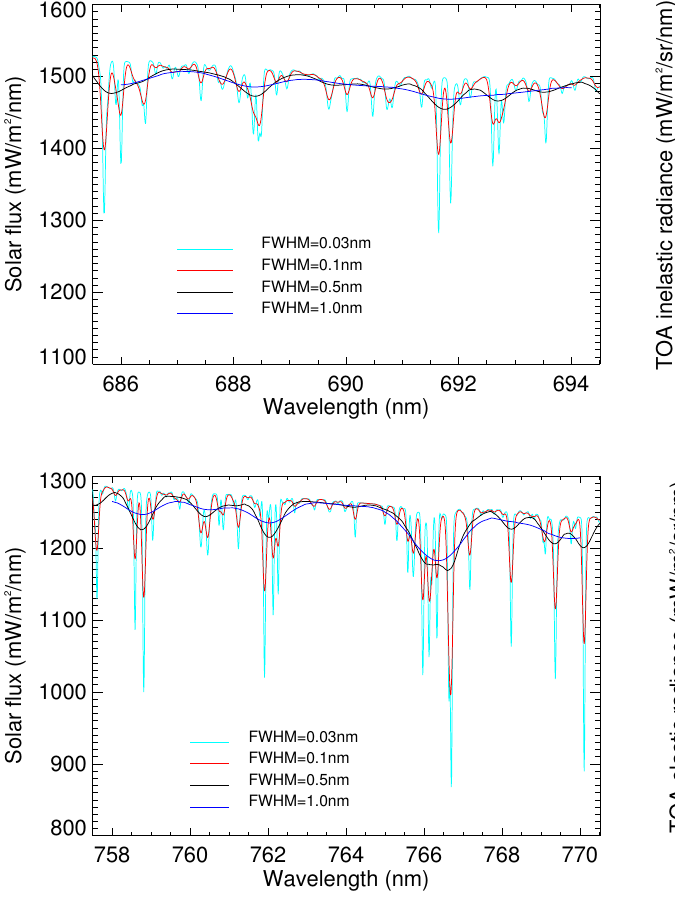
Fig. 2. Solar irradiance in the vicinity of O 2 B- (top) and O 2 A- (bottom) bands.